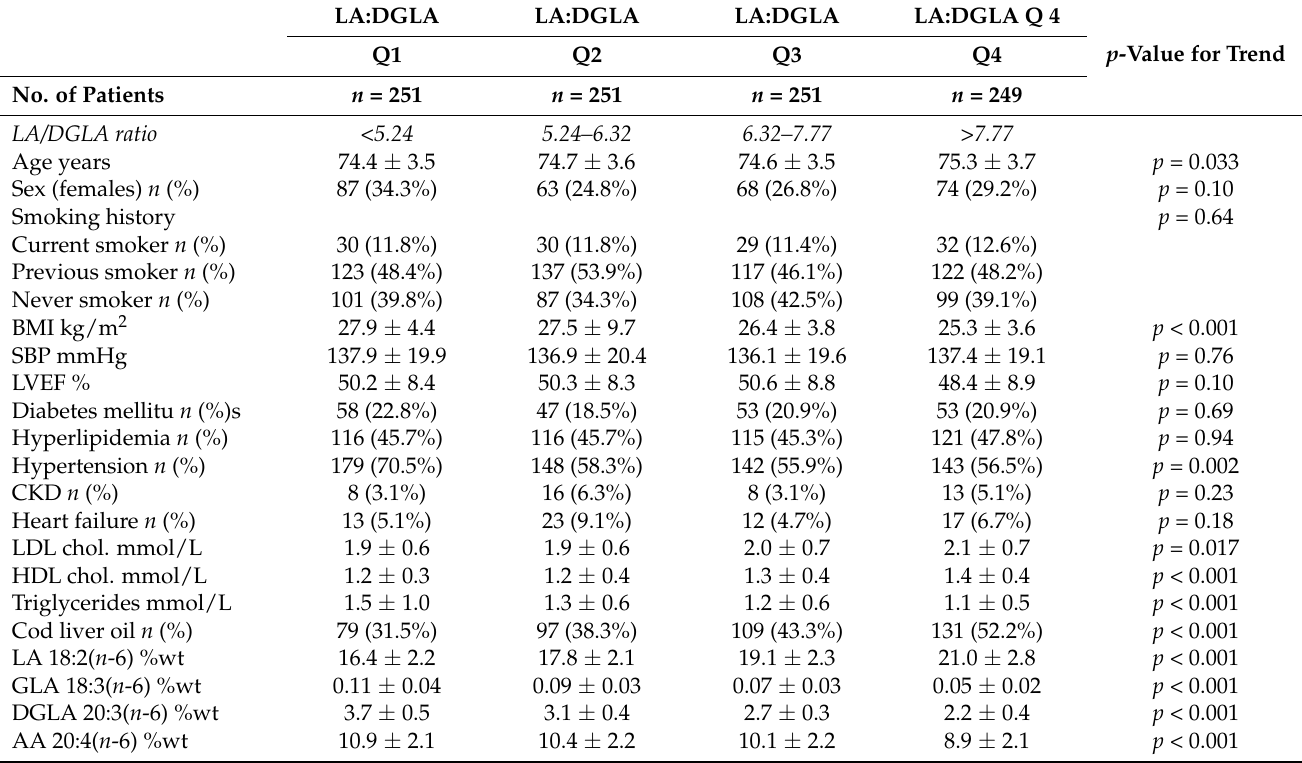
Table 2. Baseline characteristics by quartiles (Q) of